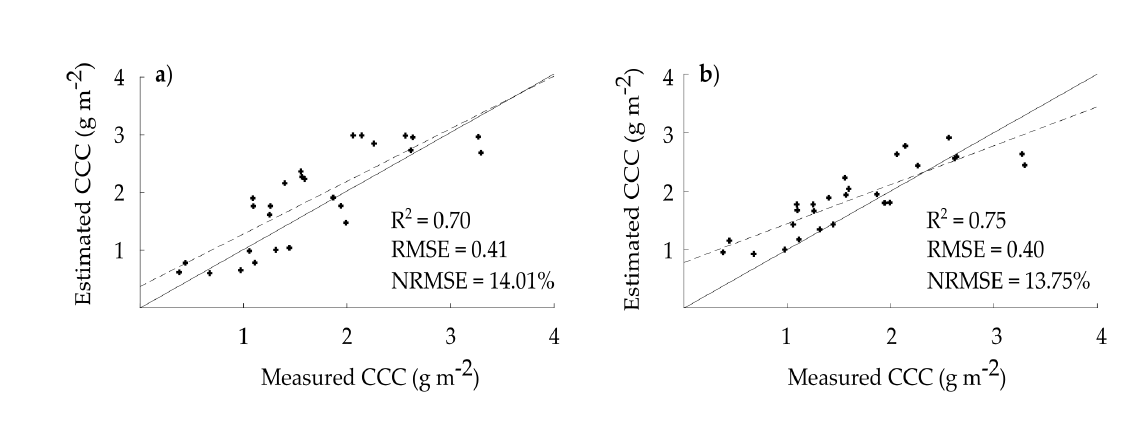
Figure A1. The estimated CCC obtained from LUTstd ( a ) and LUTreg ( b